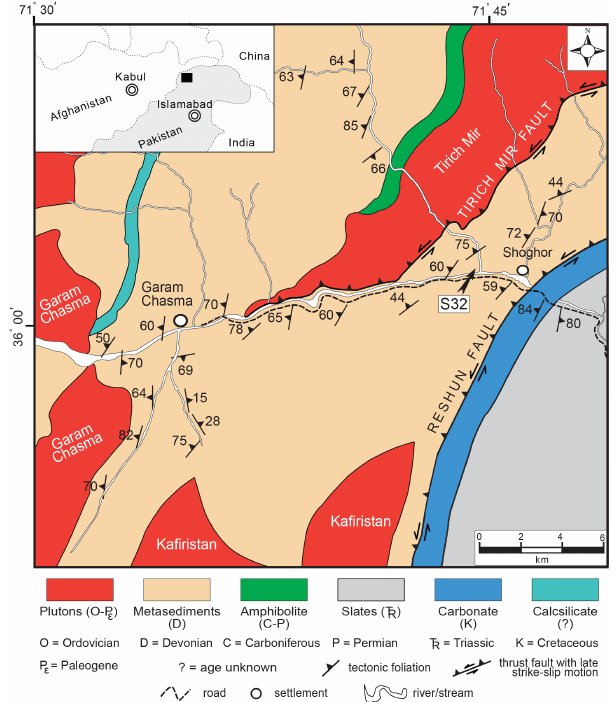
Figure 1. General geology map of the Garam Chasma/Chitral re- gion, NW Pakistan (after Faisal et al., 2014). Specimen collection location is indicated. Field area location is shown in regional scale inset